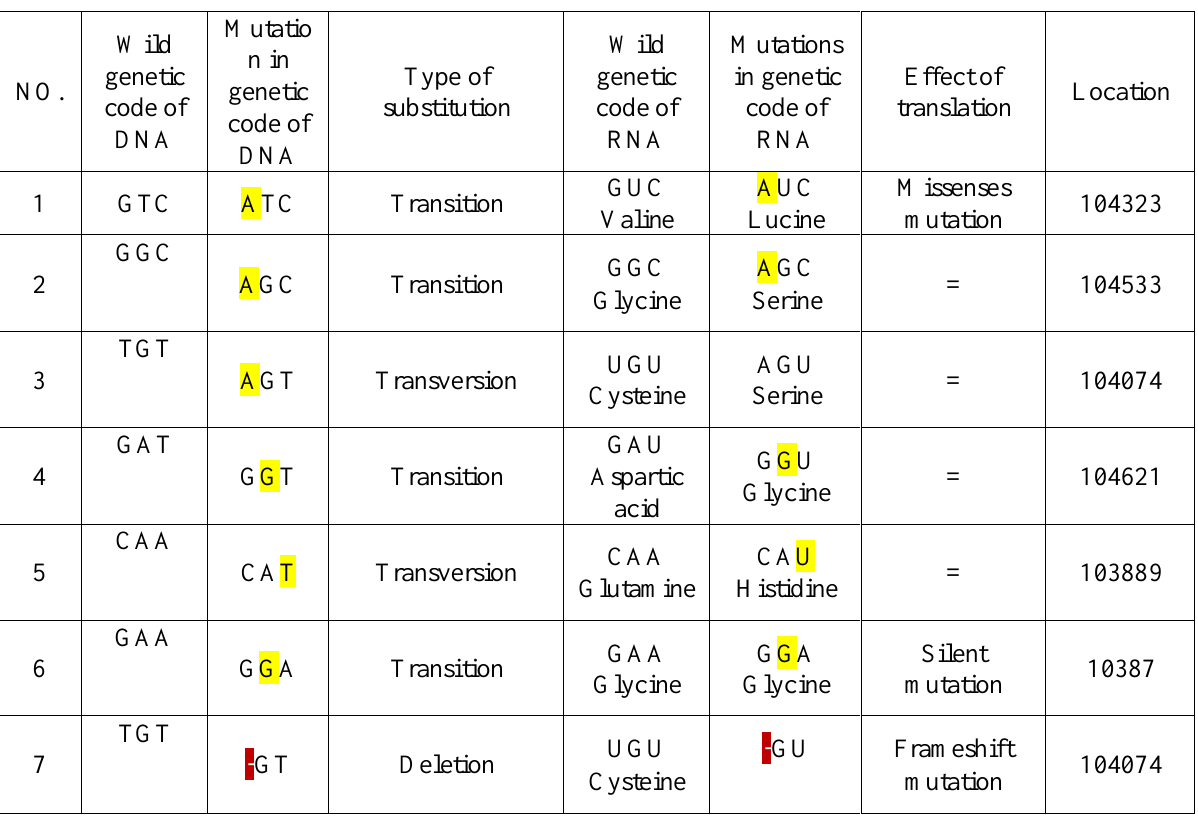
Table 4: The simple results of sequencing and type of mutation in DNA level and RNA levels with the effect that occurs after translation.